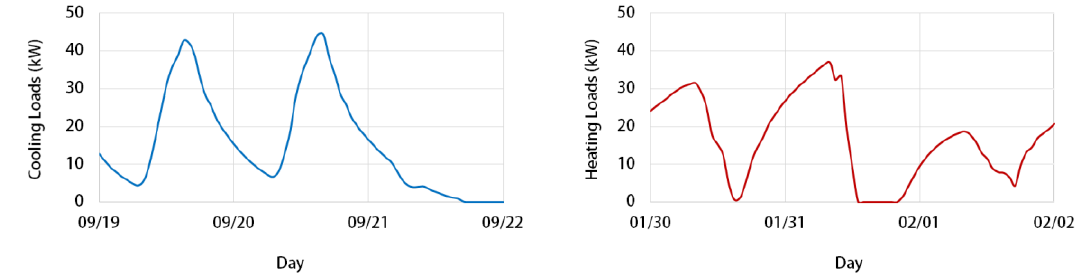
Figure 6. Daily cooling/heating loads of the hospital building.